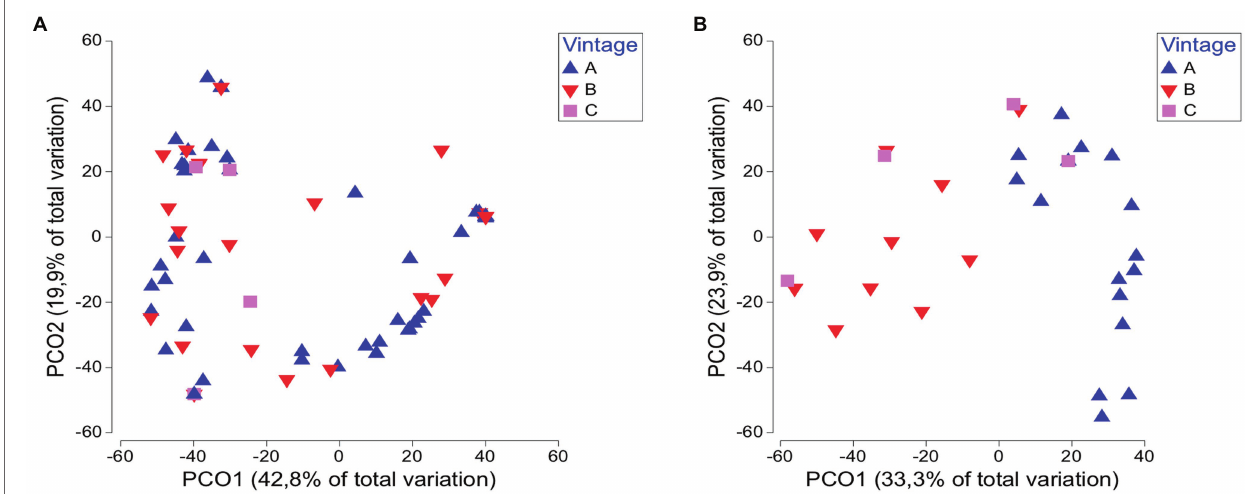
FIGURE 5 | PCoA score plot of yeasts communities across vintages: (A) all regions and (B) Santorini.